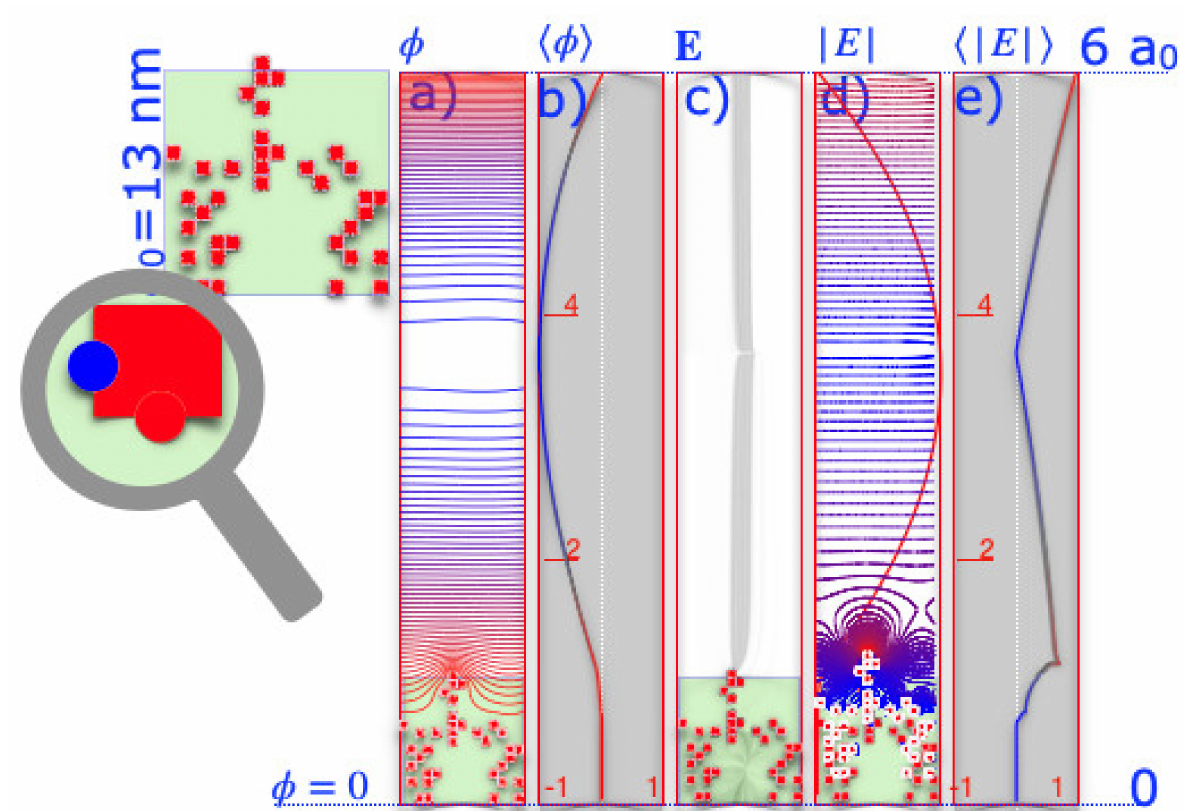
Figure 6. Negative (blue) and positive (red) charges are distributed at the edges of red squares. Based on the distribution, the Poisson equation is solved. At the edges of the red squares and the edges at z = 0 and z = 6 · a 0, the potential is set to zero. Periodic boundary conditions are specified in the x-direction. ( a ) The potential, φ and ( b ) the average potential, (cid:104) φ (cid:105) are calculated. ( c ) Line integrals represent the electric field, E , ( d ) absolute value of the electric field, | E | , and ( e ) the average total weight of the electric field, (cid:104)| E |(cid:105)